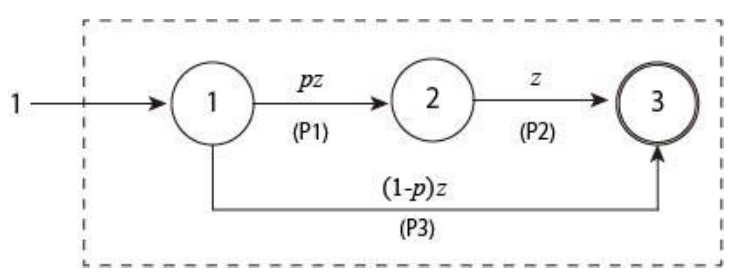
Figure 4. Phase structure for the software debugging process in Model